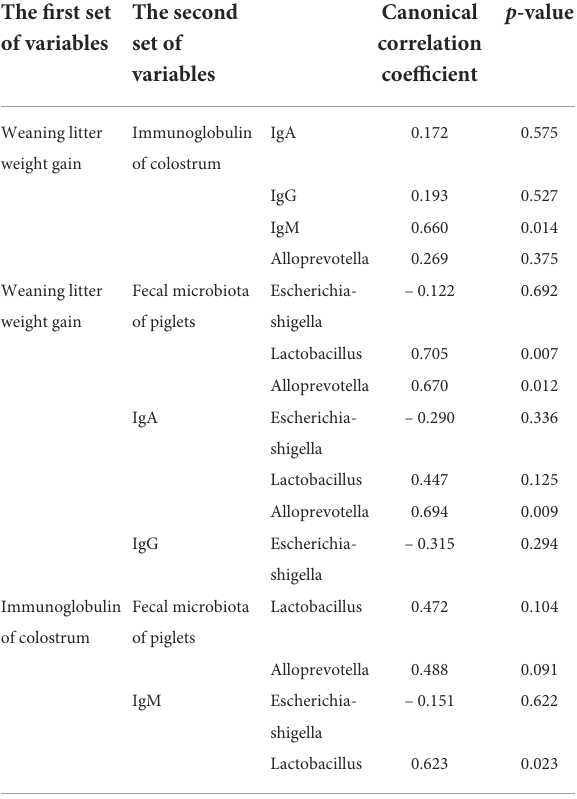
TABLE 2 Canonical correlations between litter weight gain at weaning and immunoglobulin of colostrum with fecal microbiota of